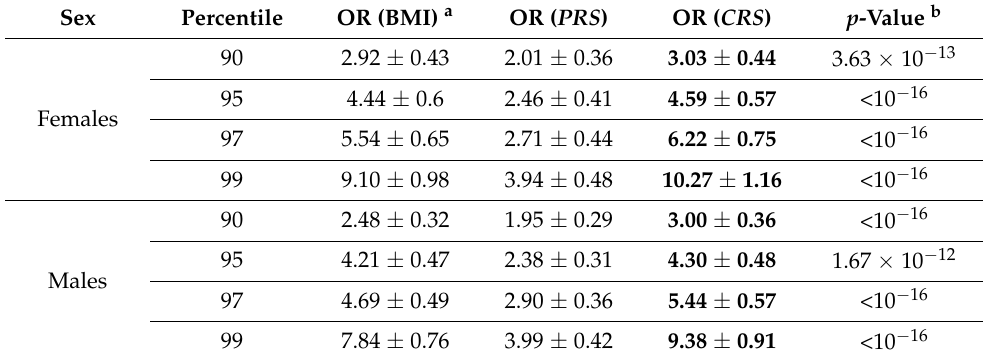
Table 1. Average OR values for T2D for the different measures (BMI, PRS, CRS) by percentiles.